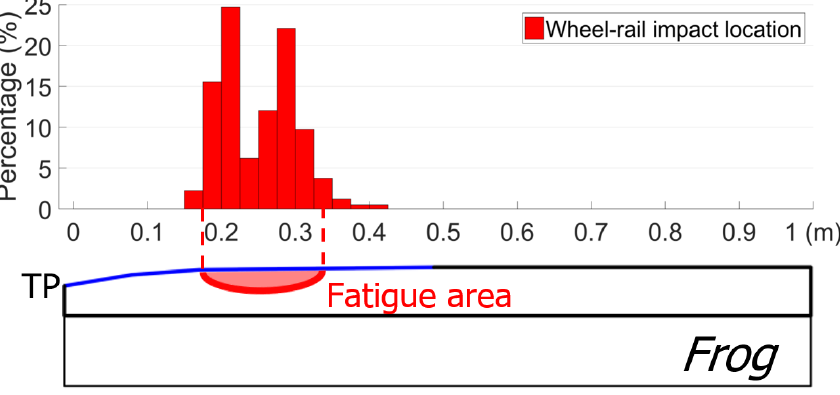
Figure 6. Example for the fatigue area detection.